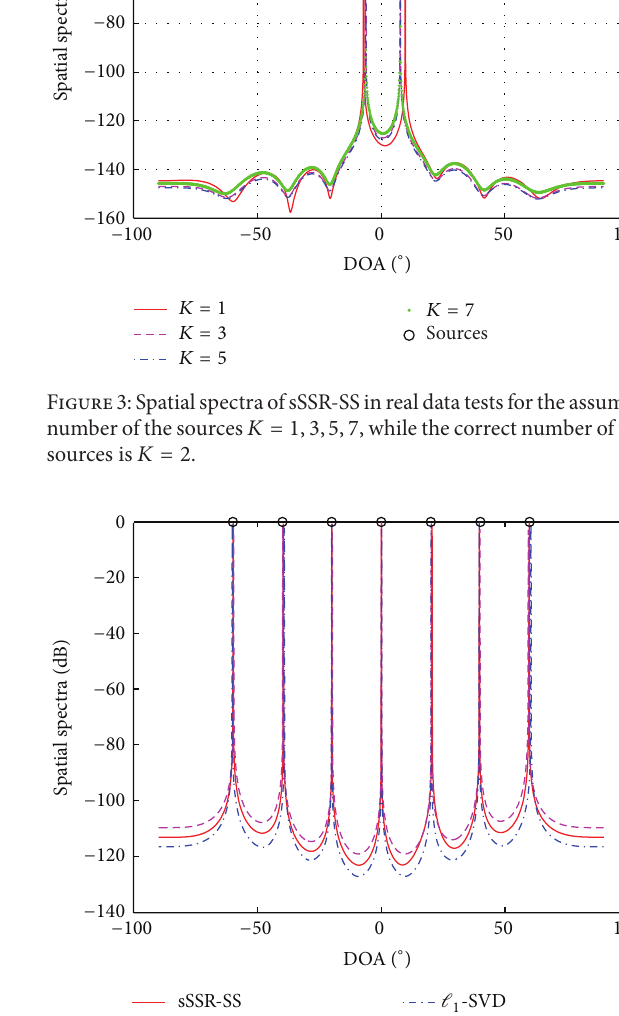
Figure 2: Spatial spectra of ℓ 1 -SVD, OGSBI-SVD, MUSIC, sSSR- AC, and sSSR-SS in numerical simulations for (a) sources from [−5 ∘ ,5 ∘ ] and (b) sources from [−5 ∘ , 0 ∘ ] . SNR = −5 dB.